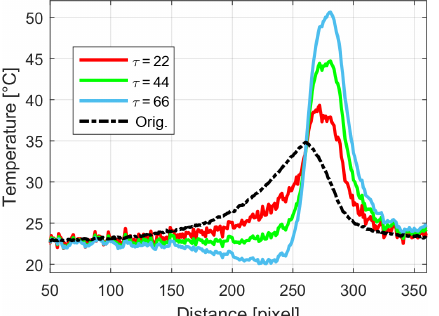
Figure 7. Images restored from Fig. 5a using different τ im values: 22 (a) and 66 (b) . Figure 8. Temperature profiles through the three restored images of Figs. 7 and 5c compared with the original one in Fig.